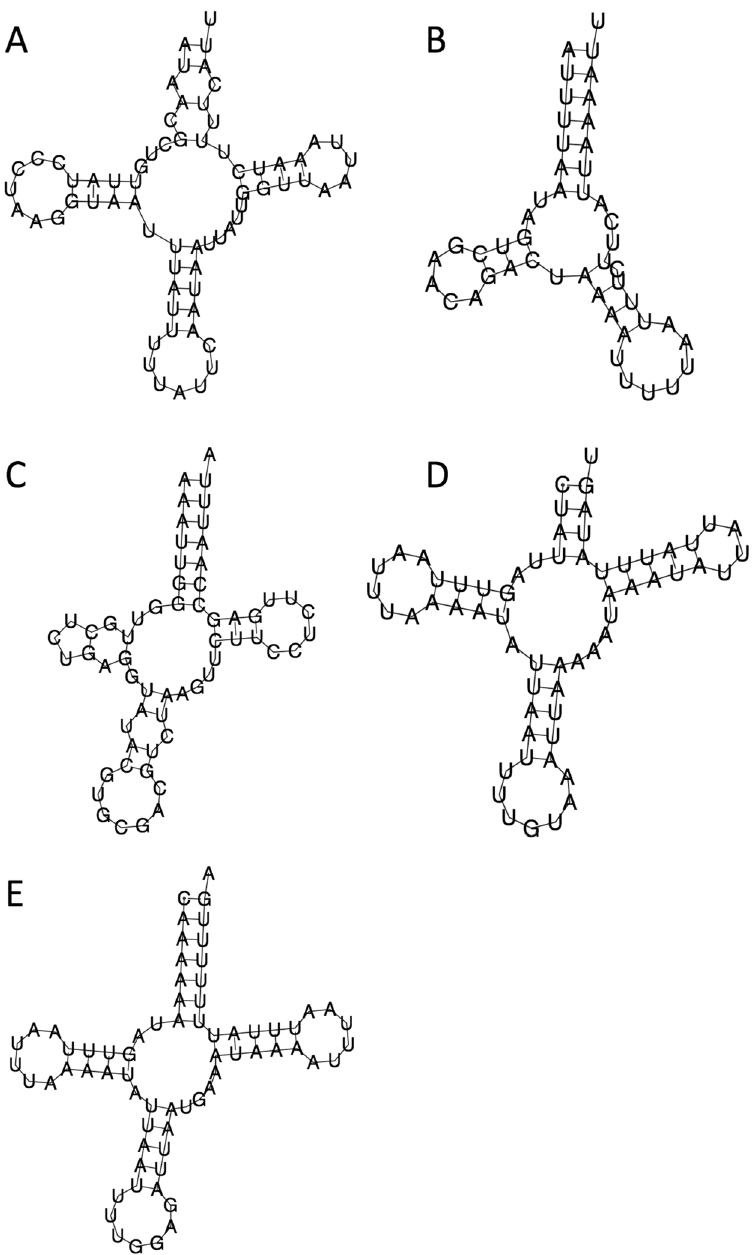
Figure 2. tRNA secondary structures of the hymenopteran parasitoid from the 1942 Japanese Bemisia sp. ( A ) The 68 bp tRNA Met has an anticodon of (TAT) and is of the typical three clover leaf structure. ( B ) The tRNA Lys is predicted to be 48 bp and has the unusual (TTT) anticodon and is lacking the T ψ C arm and loop. The tRNA Arg is 60 bp in length and has the (GCG) anticodone ( C ); the tRNA Thr ( D ) is 61 bp in length, and the tRNA Pro is 69 bp in length ( E ), and have the (TGT) and (TGG) anticodons,